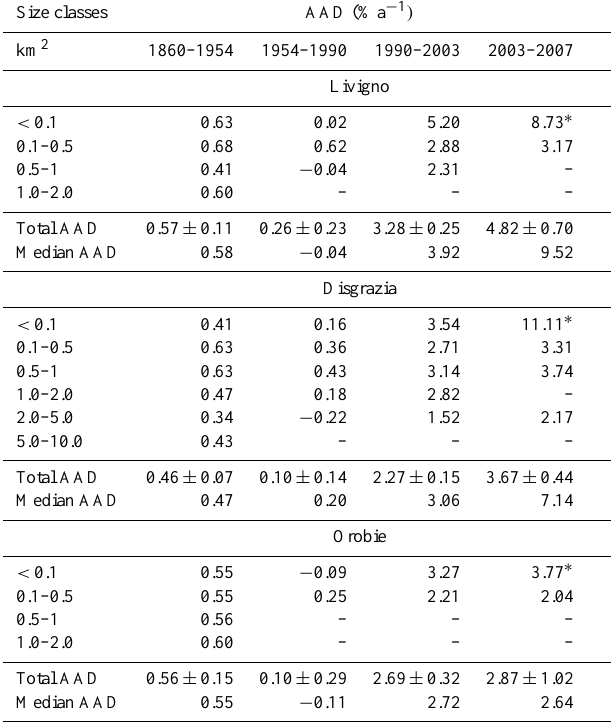
Table 4. Relative change rate in glacier area, expressed as average annual decrease (AAD) across glacier size classes.